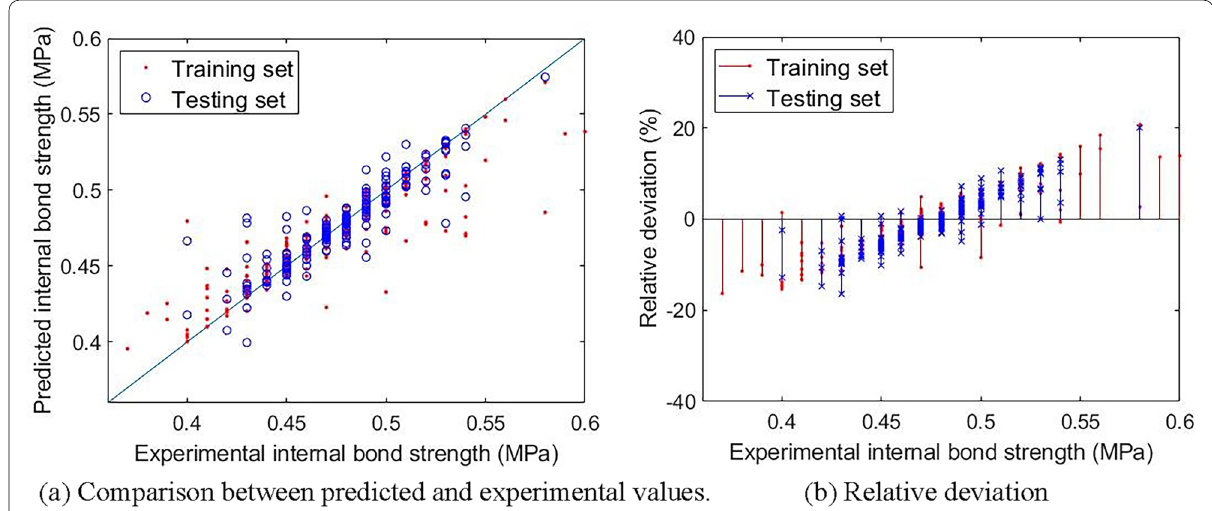
Fig. 7 Comparison and relative deviation between predicted and experimental values. a Comparison between predicted and experimental values. b Relative